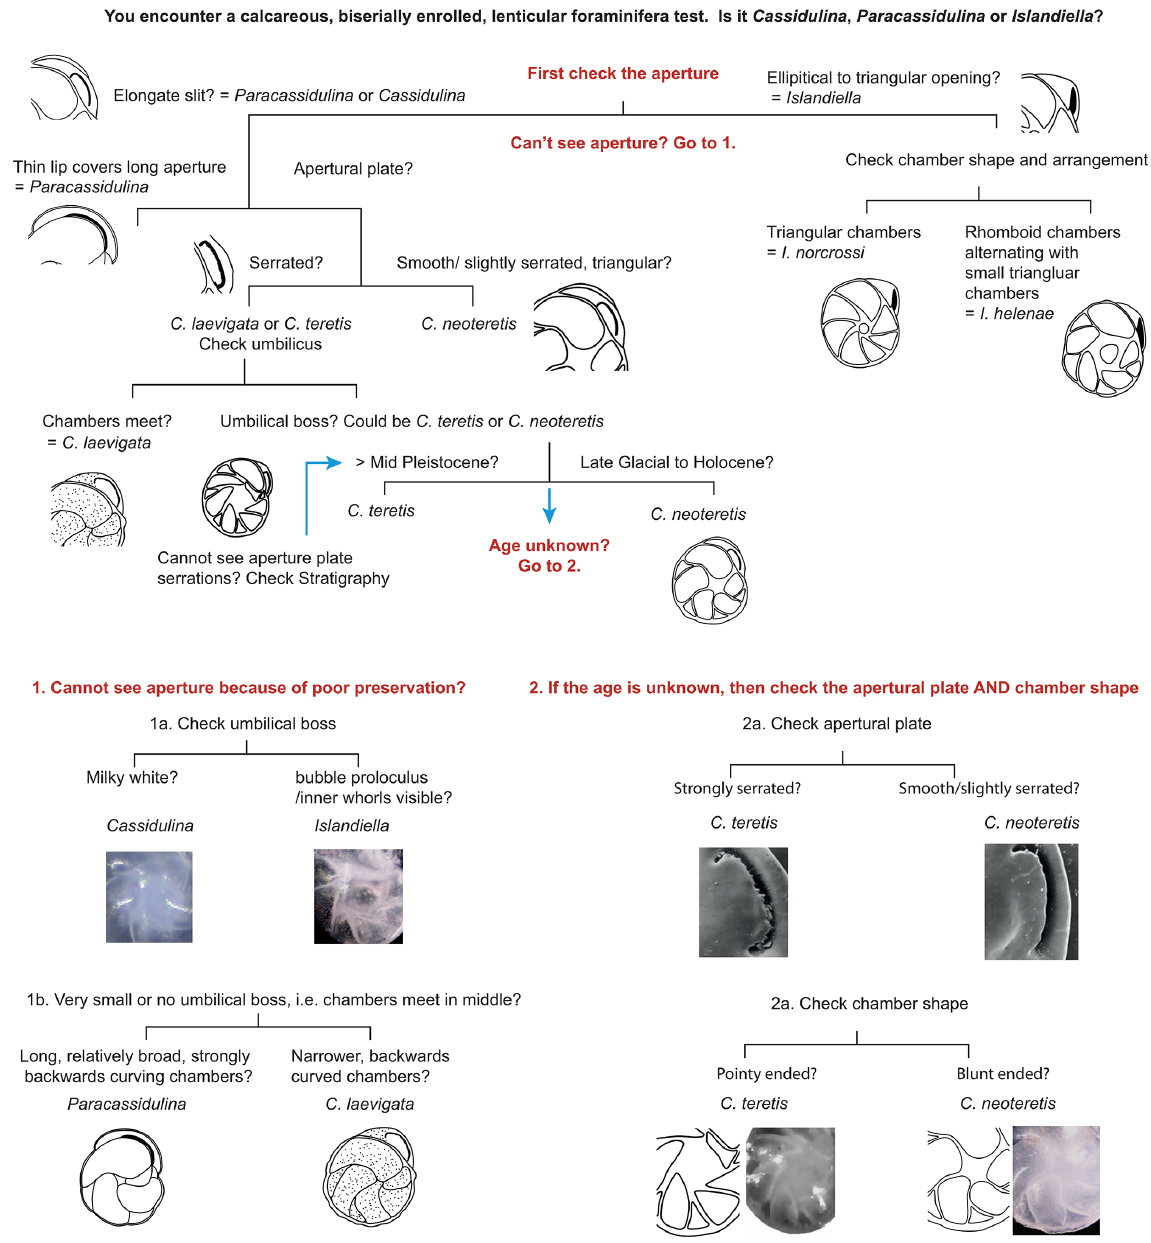
Figure 6. Decision tree to aid identification of Cassidulina laevigata , Cassidulina neoteretis , Paracassidulina neocarinata , Islandiella hele- nae , and Islandiella norcrossi . Images of C. neoteretis and C. teretis are reproduced by permission from the Journal of Micropalaeontology